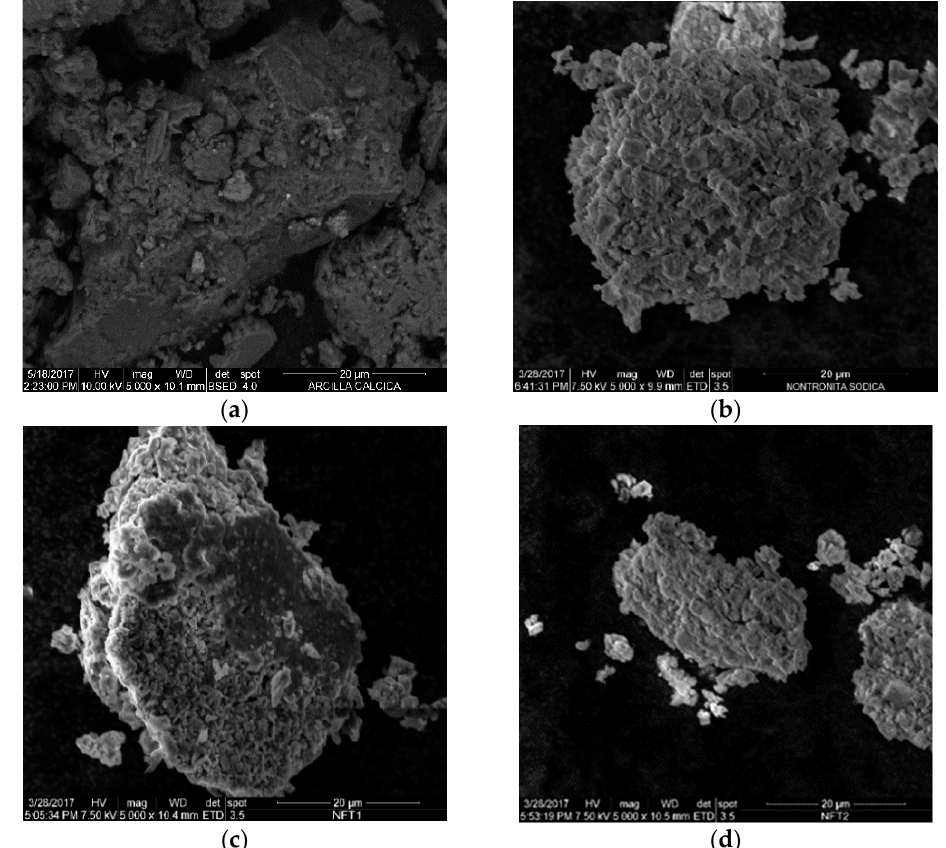
Figure 13. SEM micrographs of ( a ) calcic and ( b ) sodic nontronite, ( c ) NFT1, and ( d ) NFT2 (5000×).